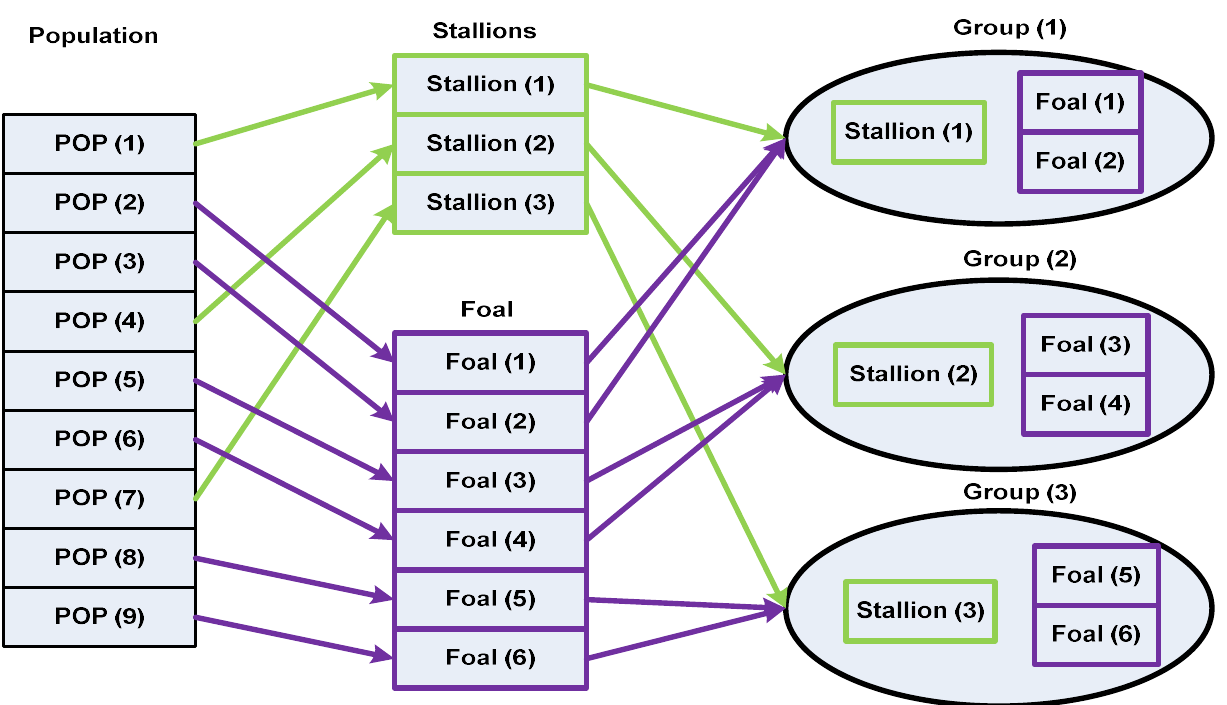
Figure 6. Forming groups from the original population.